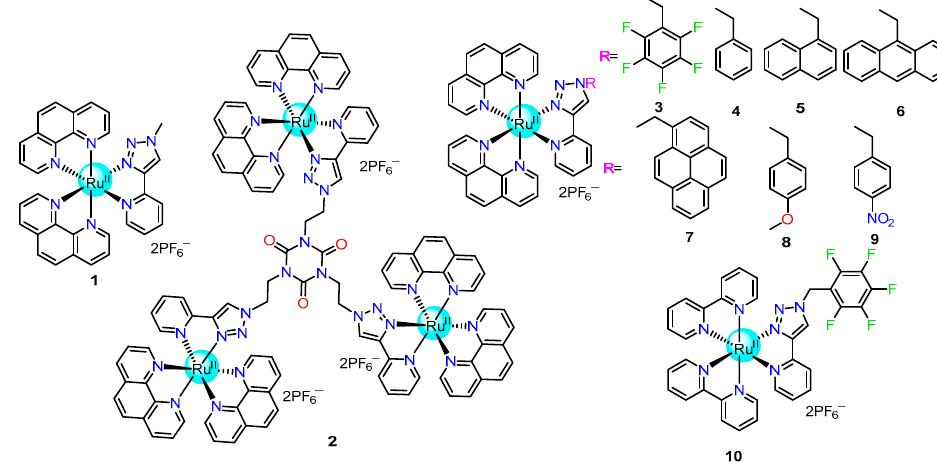
Figure 2. Structures of triazole-based Ru(II) complexes 1 –